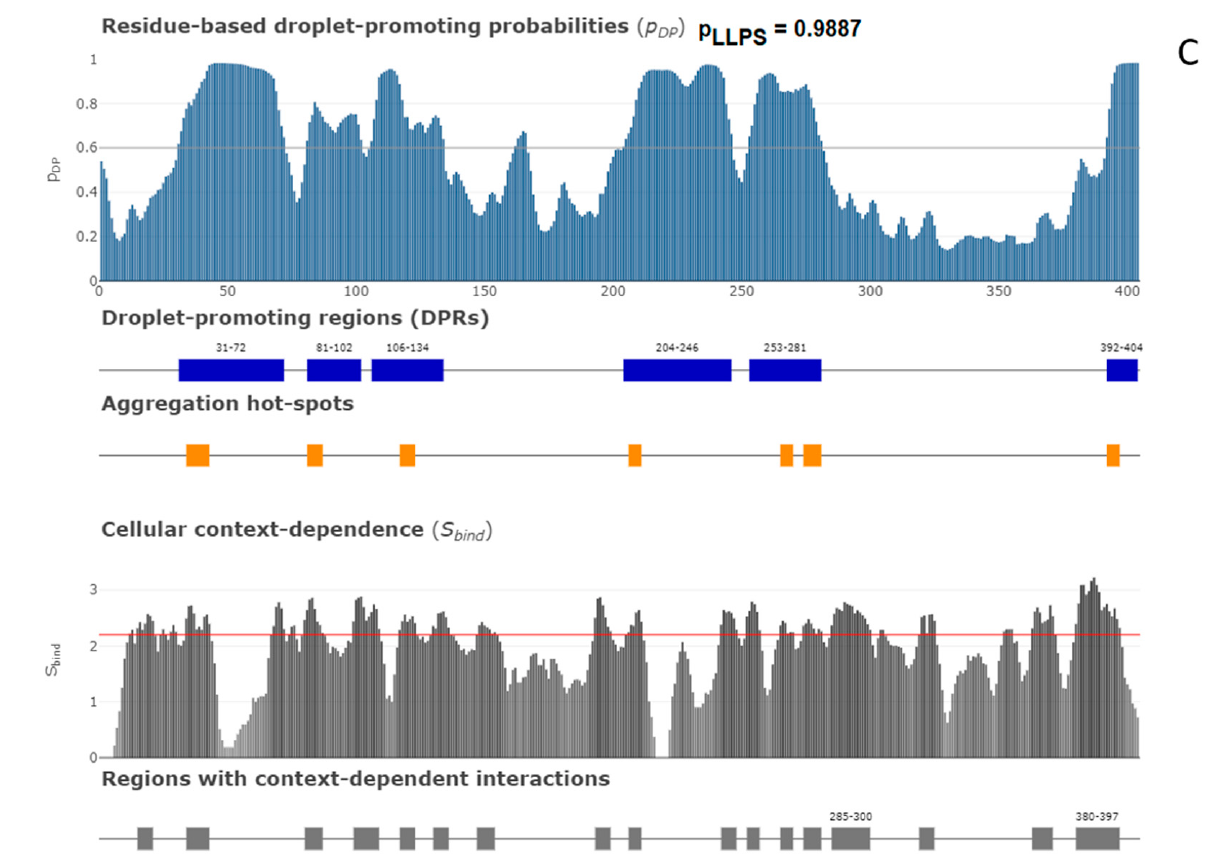
Figure 2. ( A ). Amino acid sequence of the bacteriocin BLF3872. ( B ). Intrinsic disorder predisposition evaluated using RIDAO [48] that aggregates the results from a number of well-known disorder predictors: PONDR ® VLXT (black line), PONDR ® VLS2 (red line), PONDR ® VL3 (green line), PONDR ® FIT (pink line), IUPred2_long (blue line), and IUPred2_short (yellow line). A thick dashed dark-pink line represents the mean disorder prediction (MDP) profile calculated by averaging the outputs of these six predictors, whereas a light pink shadow shows the corresponding error distribution. The results of residual disorder propensity estimation using these tools are presented as real numbers from 0 (ideal order prediction) to 1 (ideal disorder prediction). To identify disordered residues and regions in the proteins of interest, a threshold of ≥ 0.5 was used. Solid and dashed horizontal lines at disorder scores 0.5 and 0.15 correspond to the disorder and flexibility thresholds. ( C ). Evaluation of the LLPS propensity of the bacteriocin BLF3872 using FuzDrop. The top plot represents the sequence distribution of the droplet- or LLPS-promoting probability (p LLPS ) and shows that BLF3872 is characterized by a very high overall p LLPS of 0.9887. Furthermore, this protein contains six droplet-promoting regions and seven aggregation hot-spots. The bottom plot represents the cellular context dependence of BLF3872, where the S BIND values characterize the ability of residues to switch between different binding modes. Here, regions with the context-dependent interactions change protein interaction behavior and binding modes under different cellular conditions. The corresponding residues/regions can be ordered or disordered with S BIND ≥ 2.25 (red line)